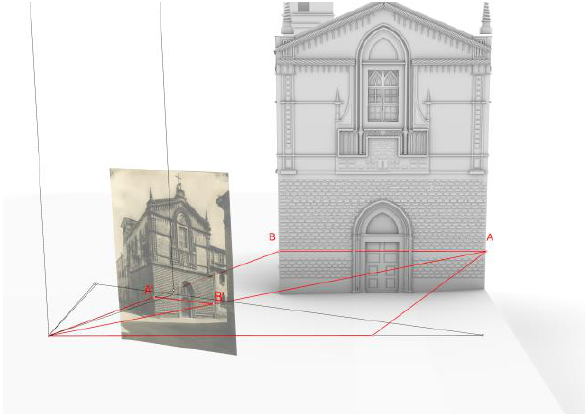
Figure 8 . External orientation with ‘parallelogram rule’.